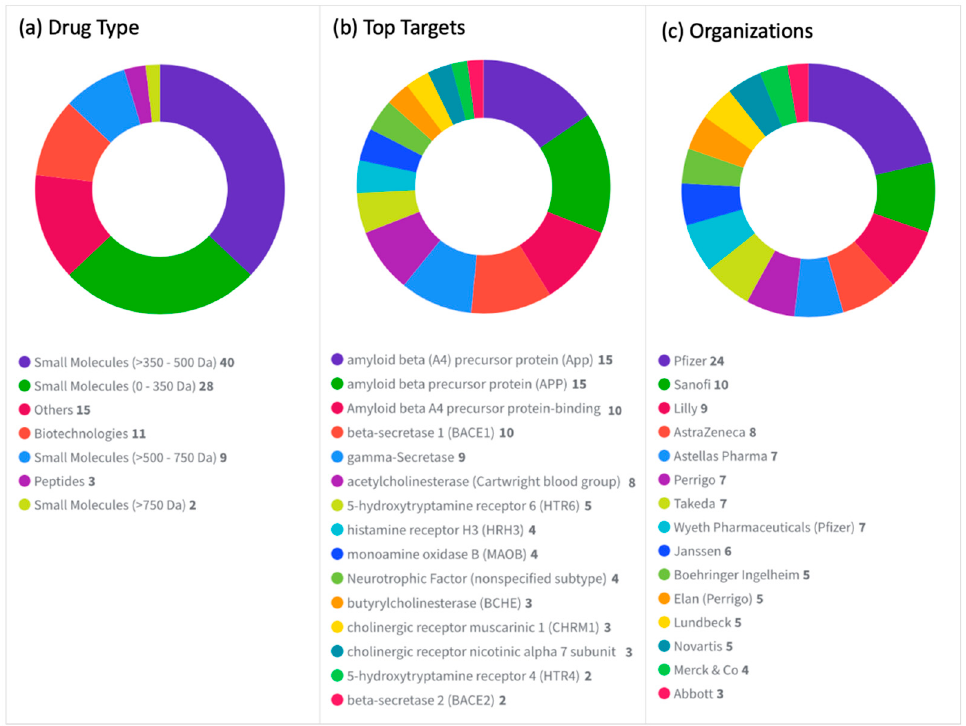
Figure 5. An overview of Alzheimer’s disease drugs that were either suspended, withdrawn, or discontinued by ( a ) drug type, ( b ) top targets, and ( c ) top organizations. Under active development, according to Cortellis Drug Discovery Intelligence (CDDI) [40] database as of 10 October 2022. Data source: Cortellis Drug Discovery Intelligence, 10 October 2022, https://www.cortellis.com/ drugdiscovery/ © 2022 Clarivate. All rights Table 4. Most important drug classes that failed as anti-AD treatments in different stages of clinical trials.